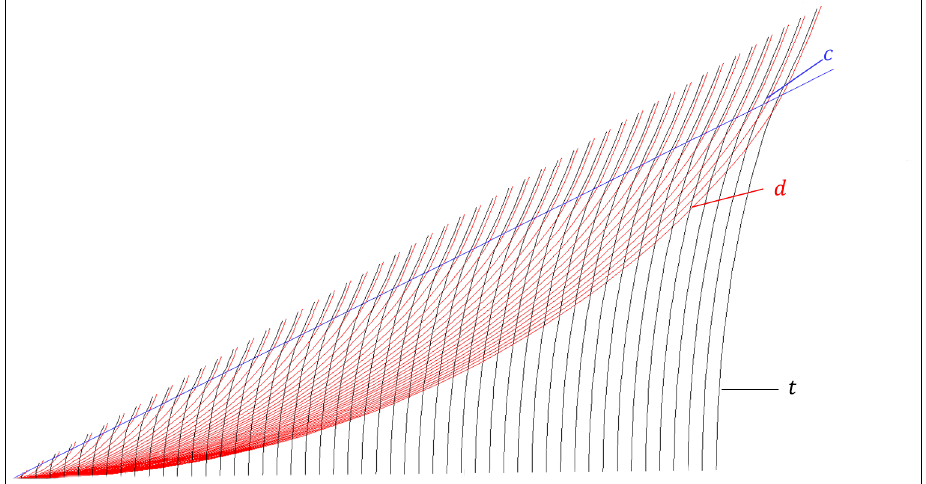
Figure 3. Wake crests diagram. Divergent ( d ) crests are in red, transverse ( t ) crests are in black. The external boundary ( c ) of the wake pattern corresponds to the cusp waves.